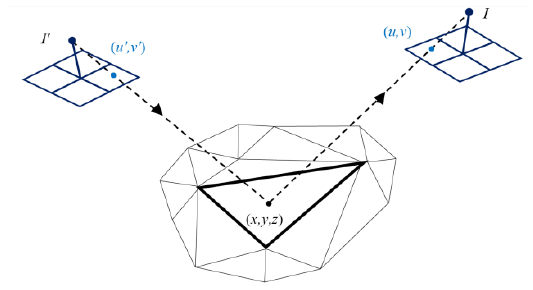
Figure 5. Illustration of an image-pair reprojection.